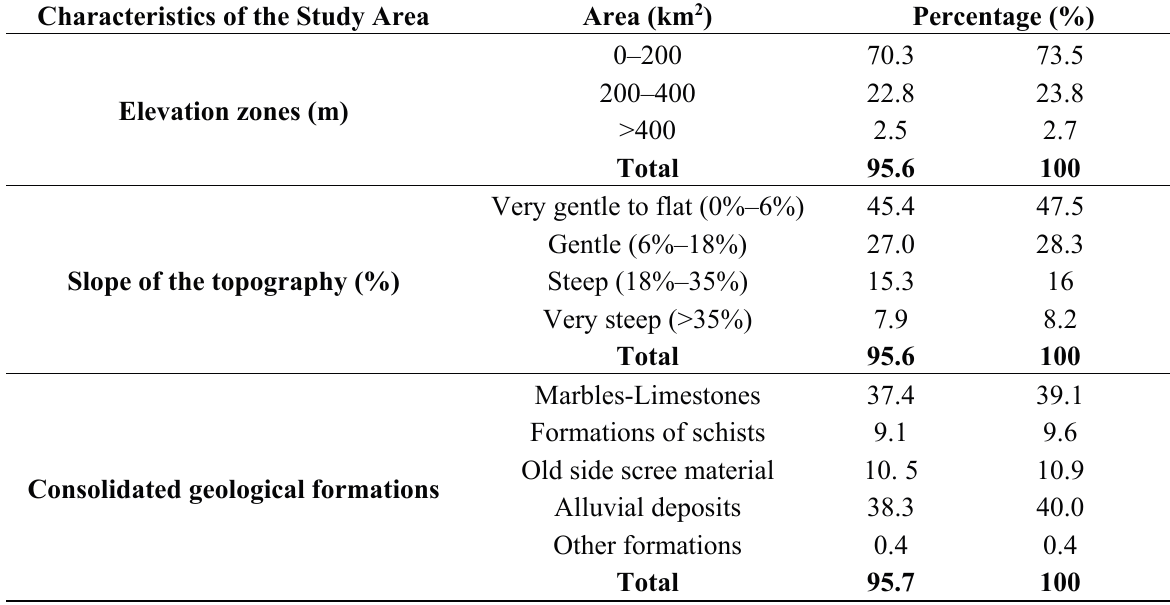
Table 1. Extent and distribution of altitude, slope and geological formations of the study